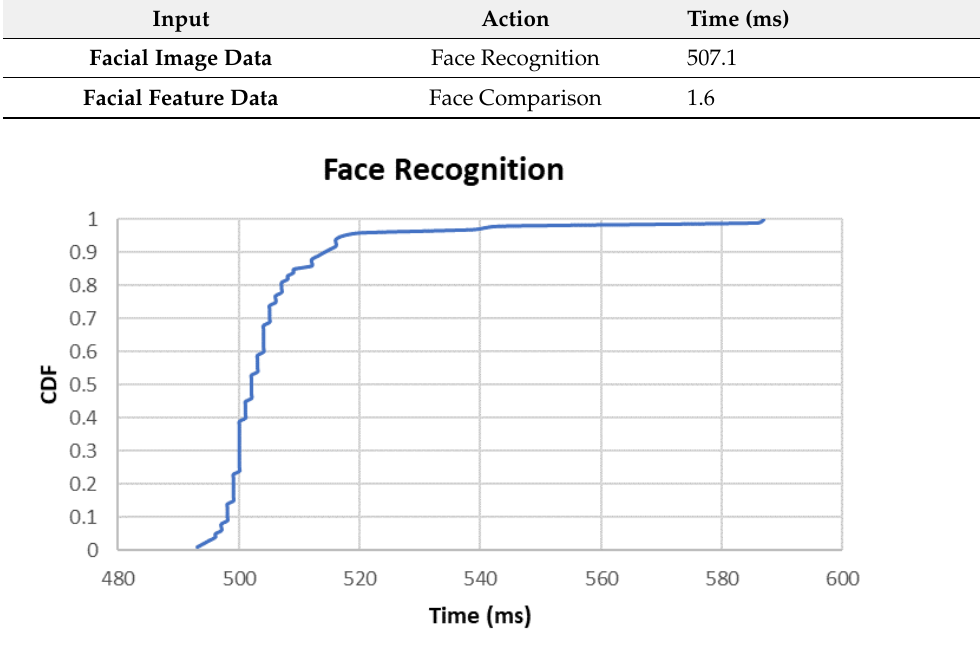
Figure 5. CDF of Time Consumption of Face